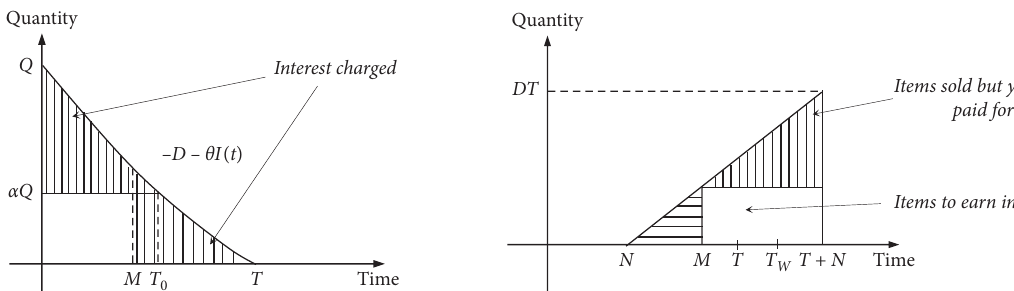
Figure 7: The earned and payable interest of the retailer when M − N ≤ T < T